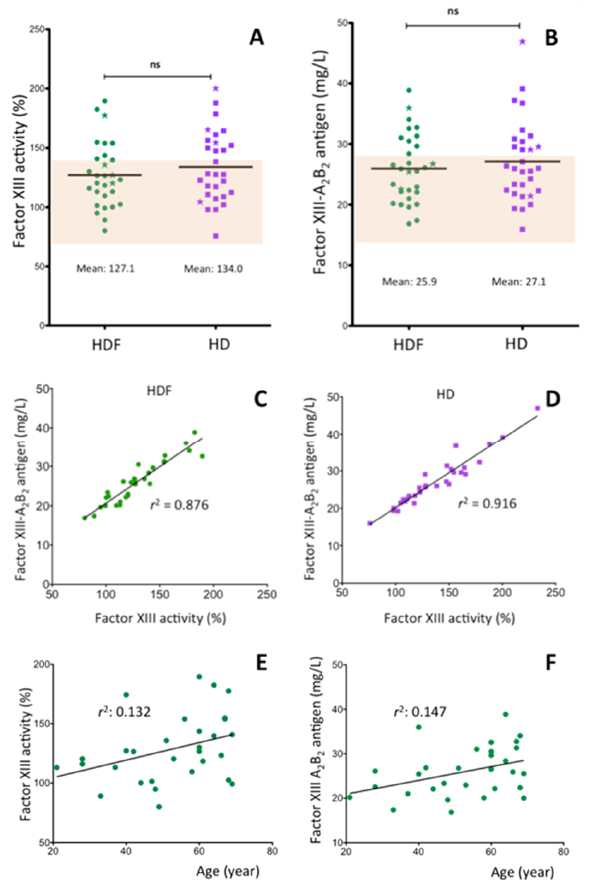
Figure 2. FXIII levels in the plasma of ESRD patients. Plasma FXIII activity ( A ) and antigen ( B ) of patients being on chronic HDF treatment or after two weeks of HD treatment. ( C ) and ( D ) correlation of the results obtained by activity measurement and immuno-assay; ( E , F ) correlation of FXIII levels with the age of ESRD patients. HDF: hemodiafiltration, HD hemodialysis, ns: not significant, r 2 : coe ffi cients of determination. The asterisks on ( A , B ) represent the four patients with the highest CRP